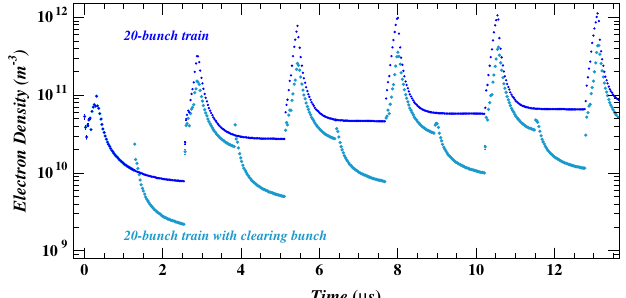
FIG. 8. Results for the beam-pipe averaged cloud density from the numerical model of electron buildup for the case of the 5.3 GeV 20-bunch train of positrons with 16-ns spacing shown in Fig. 6, with and without an intermediate clearing bunch.